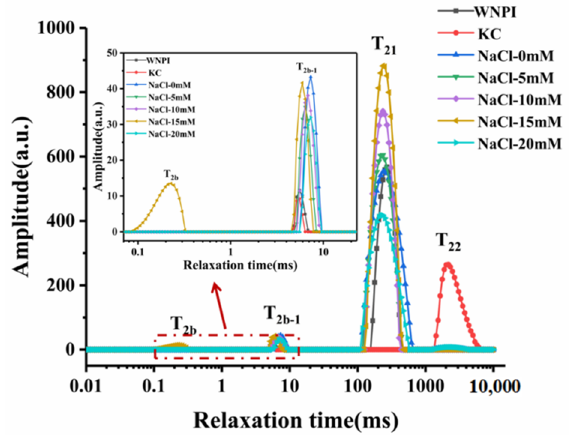
Figure 3. T 2 relaxation times distribution of WNPI-KC composite gel samples with NaCl. Table 2. T 2 relaxation times and relative peak areas of WNPI-KC composite gel samples with NaCl.